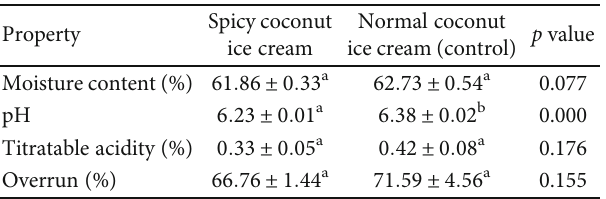
Table 1: Comparison of physical properties of spicy coconut ice cream with control.